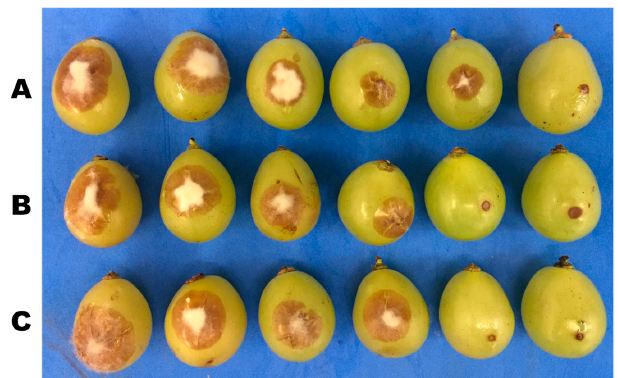
Figure 2. Decay severity (lesion diameter, mm) caused by Botrytis cinerea on ‘Italia’ table grapes untreated or treated with different concentration of potassium bicarbonate (PB), sodium silicate (SSi), and calcium chelate (CCh) after 4 days of incubation at 23 ± 1 °C. Values marked with the same letters are not statistically different by Fisher’s protected least significant difference test at p ≤ 0.05. Biomolecules 2019 , 9 , x FOR PEER REVIEW